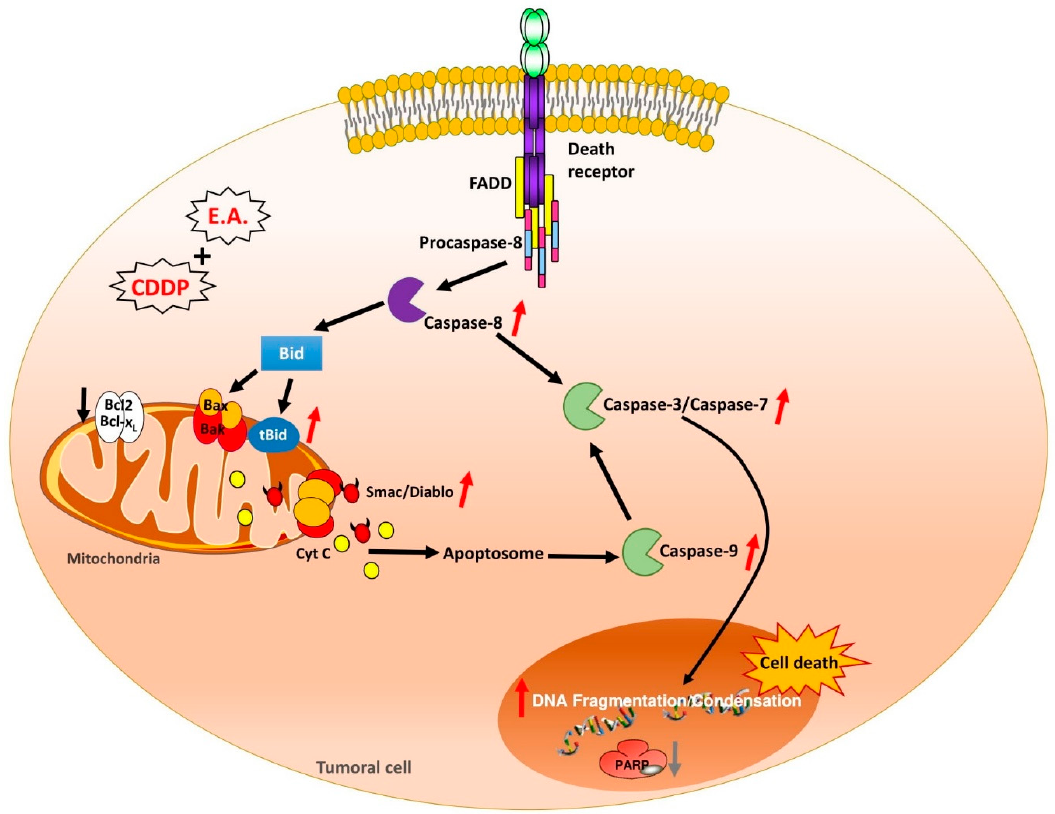
Figure 8. Key regulators modulated by an E.A./CDDP combination in breast cancer cells. E.A./CDDP acts on the intrinsic pathway of apoptosis by decreasing the expression of BCL ‐ 2 and BCL ‐ x L anti ‐ apoptotic proteins and by increasing the expression of Bax and Bak proteins. The relocalization of Bax into mitochondria would allow the release in the cytosol of pro ‐ apoptotic molecules contained in the mitochondrial intermembrane space, allowing then the activation of the procaspase ‐ 9 in caspase ‐ 9, which, once activated, will turn on caspase ‐ 3. Also this E.A./CDDP combination is able to activate capsase ‐ 8, one of the apoptotic markers of the extrinsic pathway allowing both the cleavage of the Bid protein, where Bid truncate will proceed to activate the mitochondrial pathway and the cleavage of procaspase ‐ 3 into active caspase ‐ 3, which will target the cleavage of PARP and then lead to cell death (FADD : Fas ‐ Associated protein with Death Domain). Supplementary Materials: The following are available online at www.mdpi.com/xxx/s1, Figure S1. LC ‐ MS ‐ MS Analysis of the main compounds identified; Figure S2. ESI ‐ MS/MS profiles of identified compounds; Table S1. Summary of the properties of the compounds detected in an Ephedra alata extract of by LC ‐ MS/MS; Table S2. Antibodies used in the study Author Contributions: F.S. performed the experiments and analyzed the data; S.A. performed cytometry and flux analysis; I.b.T. performed the LC ‐ MS ‐ MS and biochemical analysis; A.L. helped in in vivo experiments; V.A. helped in setting up the project and analyzed the data; L.C. ‐ G. and D.D. wrote the manuscript and supervised the overall project. All authors have read and agreed to the published version of the manuscript. Funding: This work was supported by a French Government grant managed by the French National Research Agency under the program “Investissements d’Avenir”, reference ANR ‐ 11 ‐ LABX ‐ 0021, and was supported by grants from the “Conseil Régional de Bourgogne” and the “Fonds Européen de Développement Régional” (FEDER). The authors acknowledge the Tunisian Higher Education and Scientific Research Ministry for the financial support of this study. Acknowledgments: The authors would like to express their most gratitude and appreciation to Professor Asma Omezzine (Biochemistry Department laboratory, CHU Farhat Hached, Sousse) for Biochemical assays and analysis.